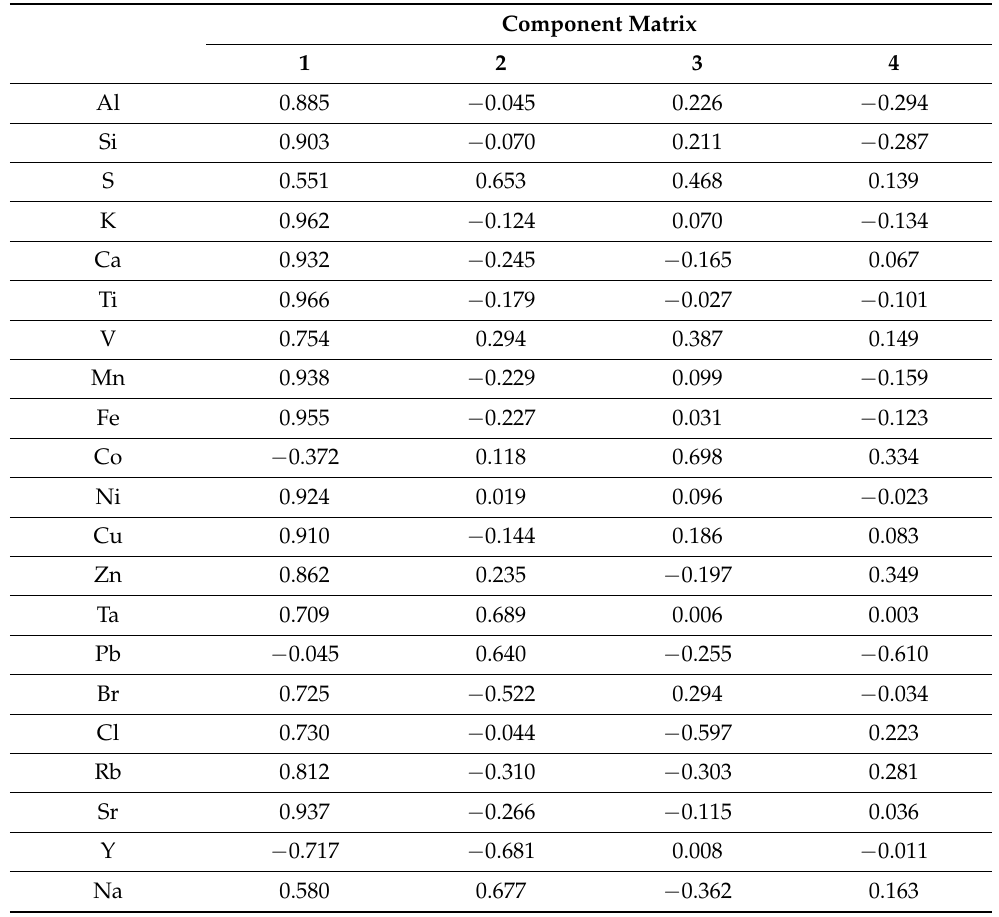
Table 7. Four components matrices for the quantified elements in PM 2.5 collected from Alnaeem